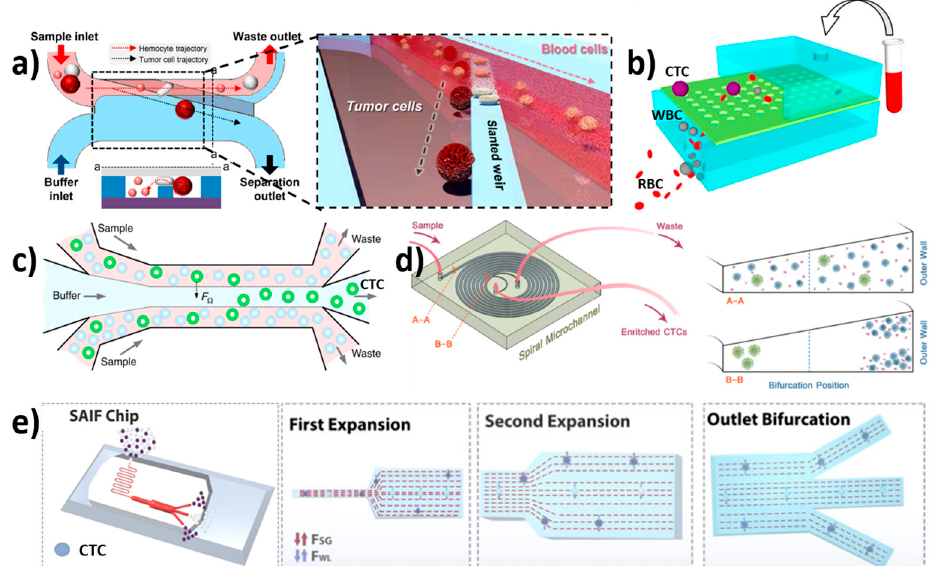
Figure 4. Schematic illustration of microfluidic devices for the isolation of CTCs using various techniques. ( a ) An overview of a slanted weir device; separation of CTCs over a slanted weir based on distinct size and deformability [93]. ( b ) Schematic of the microfluidic device integrated with a PDMS microfiltration membrane for CTC capture; reprinted with permission from ref. [90], 2015, Elsevier. ( c ) Top view of the multi-flow effect of a size-dependent inertial migration microfluidic system representing rotation-induced lift force (F Ω ) for the isolation of CTCs [62]. ( d ) Enrichment of CTCs using spiral microfluidic technology utilizing inertial lift force [120]. ( e ) Illustration chip, self-amplified inertial-focused cell bifurcation of CTCs in the microfluidic channel; reprinted with permission from ref. [121], 2020, American Chemical Society.